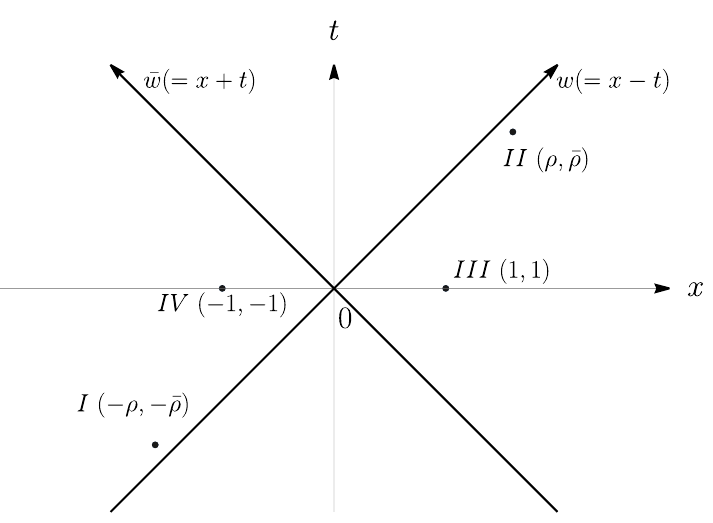
Figure 13 . A schematic of the four insertion points on the ρ plane. We have drawn both the x and t as well as the w and ¯ w axes on this graph. The values of coordinates are given in w and ¯ w